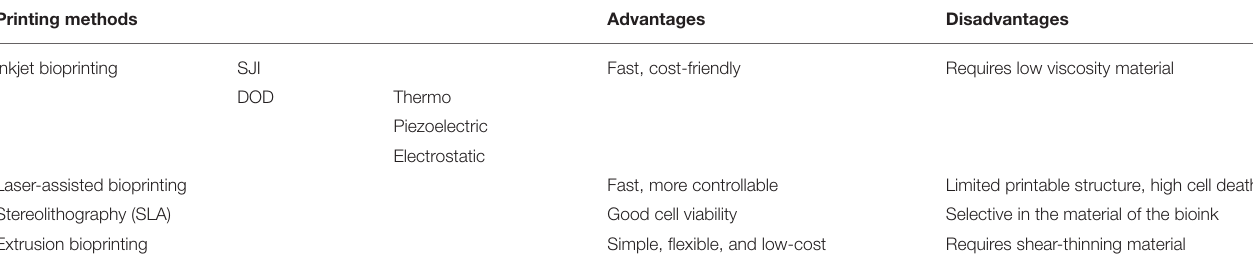
TABLE 3 | A summary of bioprinting